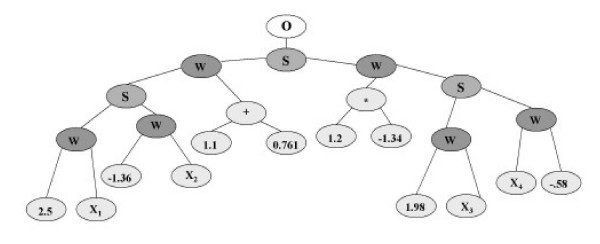
A NN evolved by GPNN. An example of a NN evolved by GPNN. The O is the output node, S indicates the activation function, W indicates a weight, and X1-X4 are the NN inputs.